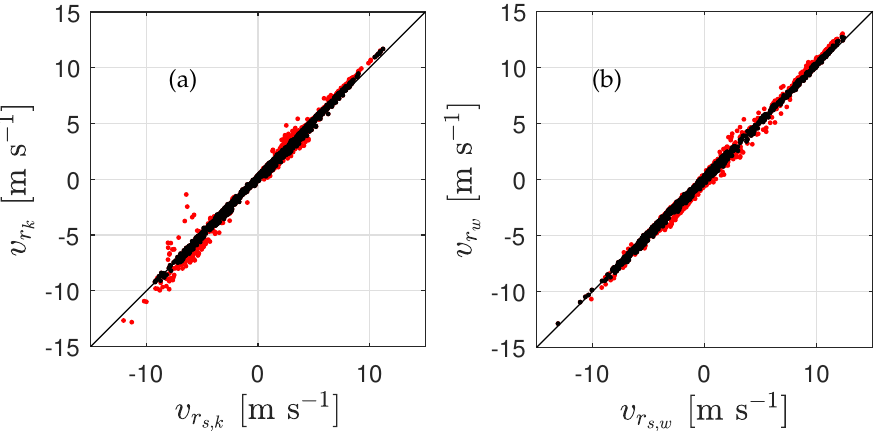
Figure 6. Scatter plot of the radial velocities of the WindScanners and the sonic anemometer in the beam direction of the k lidar ( a ) and w lidar ( b ). The red markers correspond to all data and the black markers to selected data (see text for details)